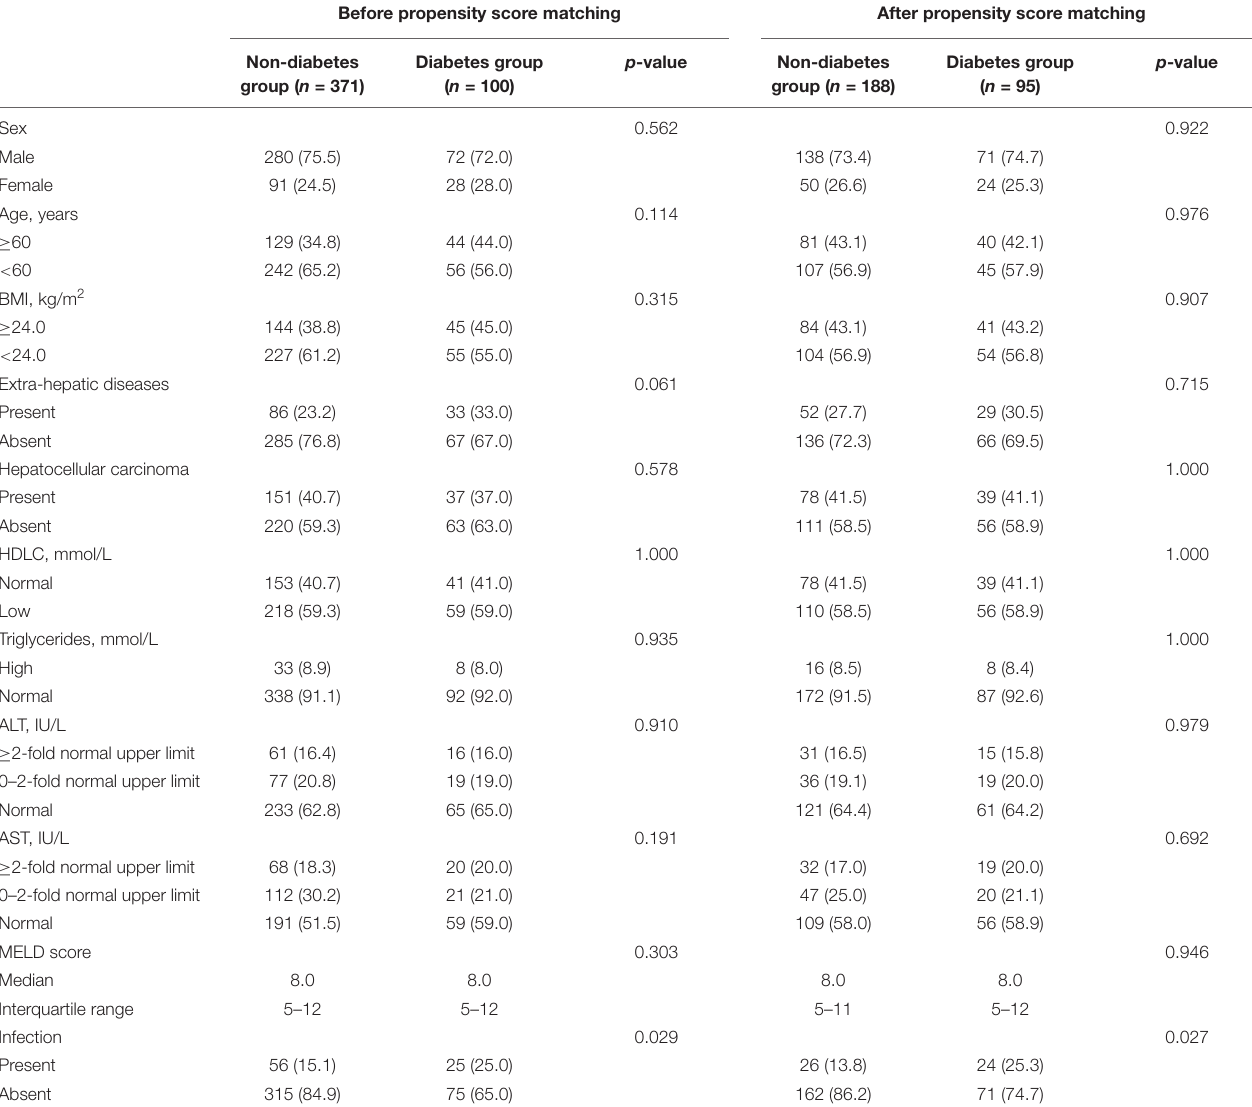
TABLE 1 | Clinical characteristics stratified by